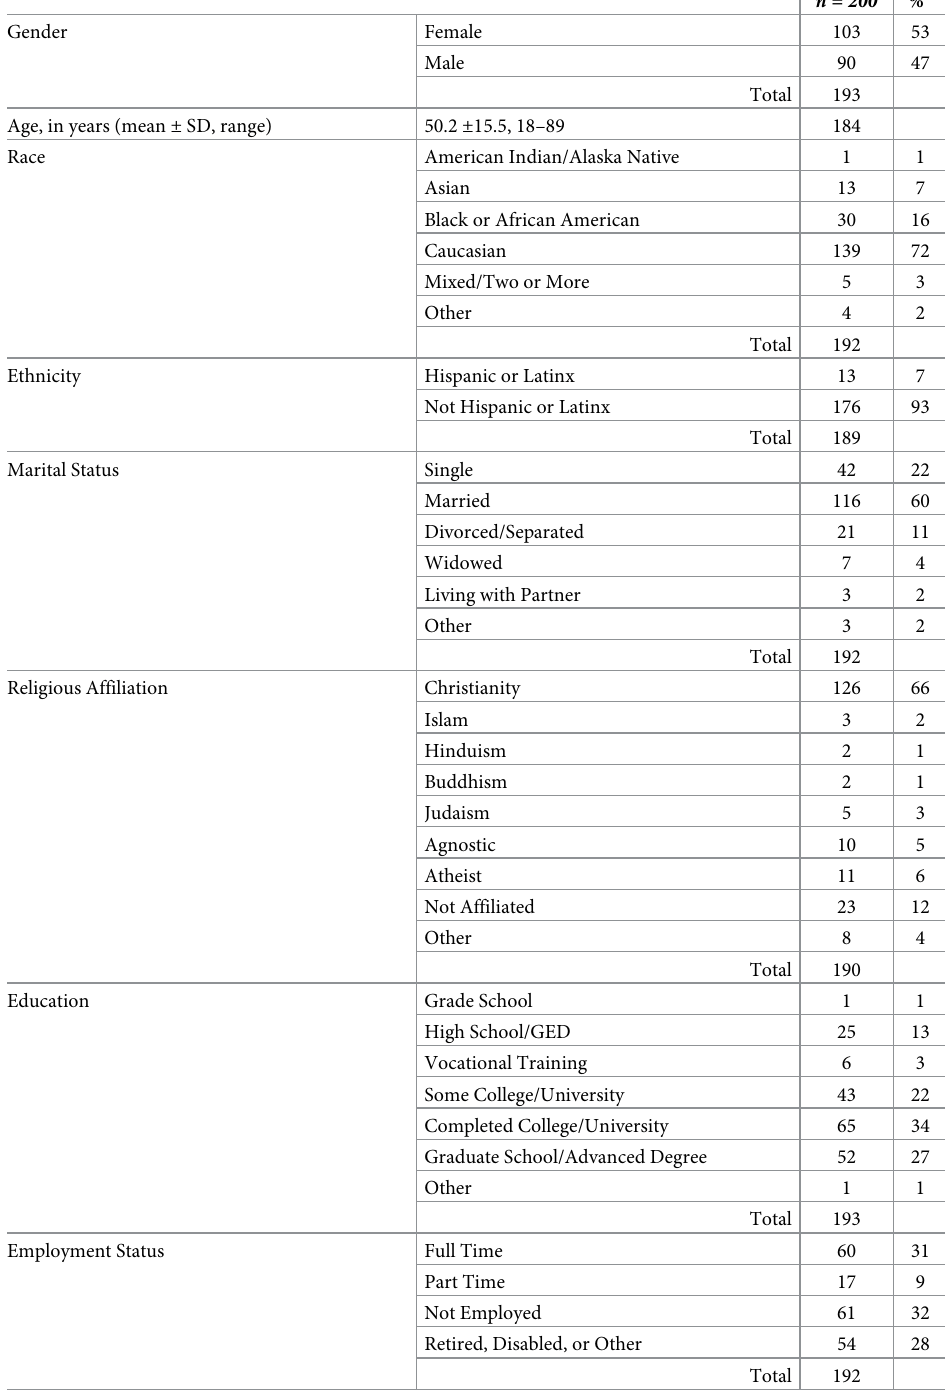
Table 1. Subject demographics of enrolled participants with serious and life-threatening